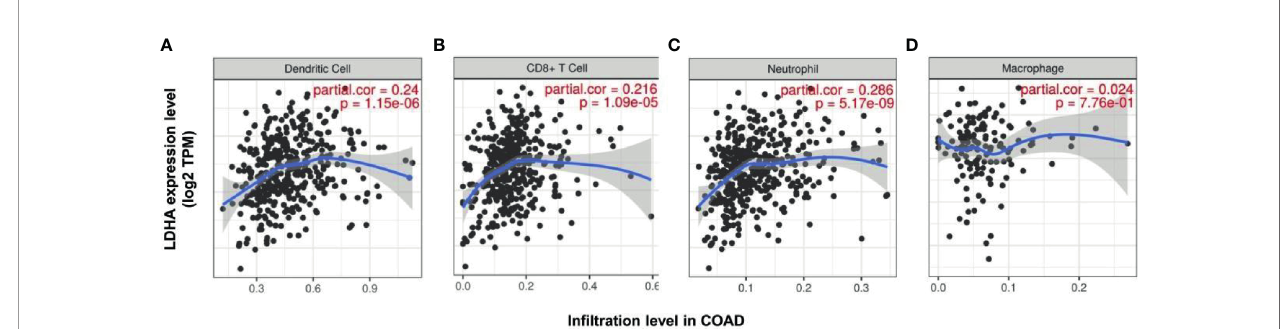
FIGURE 5 | Correlation between the expression of LDHA and the level of immune in fi ltration in COAD. The correlation between the expression of LDHA and the immune in fi ltration of dendritic cells (A) , CD 8+ cells (B) , neutrophils (C) , and macrophages (D) in COAD.